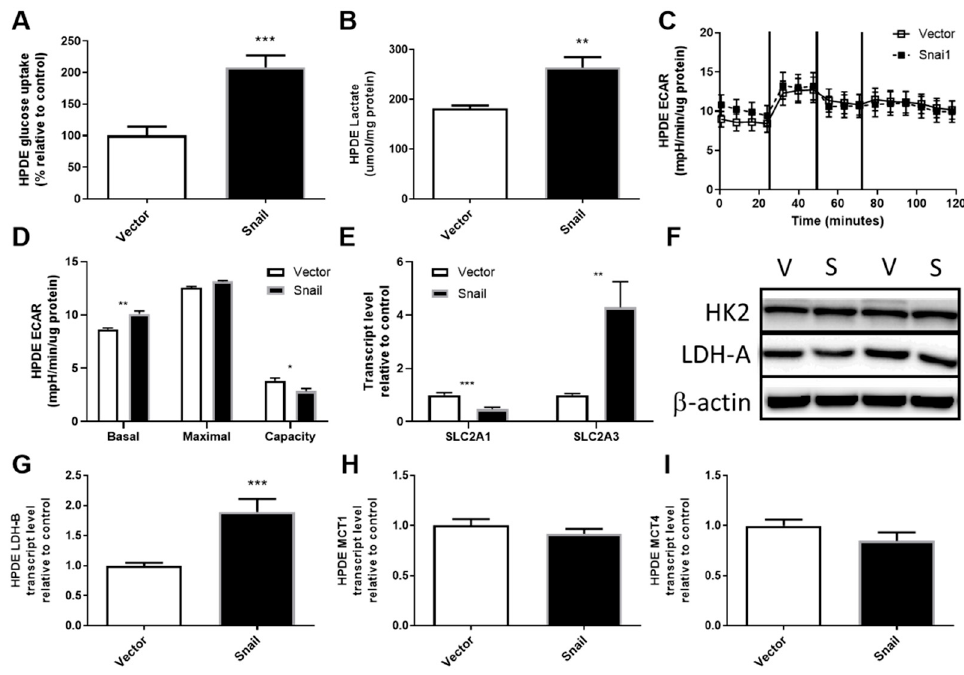
Figure 4. E ff ects of Snail overexpression on glucose uptake and lactate production in HPDE cells. ( A ) Rate of glucose uptake measured by 3 H-2-Deoxy-Glucose tracer over an 8 min period. ( B ) Lactate assay performed on cell culture media collected after 72 hours of culturing. ( C ) Extracellular acidification rate (ECAR) measured using the Seahorse XF96 Analyzer at basal levels for 30 min followed by sequential injections of 1 µ M oligomycin, 0.5 µ M Carbonyl cyanide-4-(trifluoromethoxy)-phenylhydrazone (FCCP) and 1 µ M rotenone at 30 min intervals. ( D ) basal and maximal glycolytic activity and glycolytic capacity calculated from Seahorse data. ( E ) Fold-change in total RNA for SLC2A1 (encoding Glut1) and SLC2A3 (encoding Glut3) measured by qPCR using β -actin as housekeeper. ( F ) Immunoblotting results for hexokinase II (HK2) and lactate dehydrogenase A (LDH-A) with β -actin as loading control. ( G – I ) Fold change in total RNA detected for lactate dehydrogenase-B (LDH-B) and monocarboxylate transporter 1 (MCT1) and 4 (MCT4). Results are shown as mean ± SEM with n = 3. ** p < 0.01, *** p < 0.001 for di ff erence between vector control and Snail-overexpressing cells.